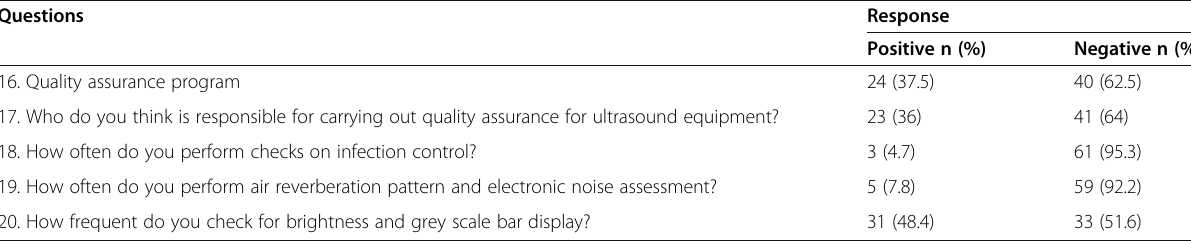
Table 3 Participant responses on the practice of quality assurance on medical ultrasound equipment